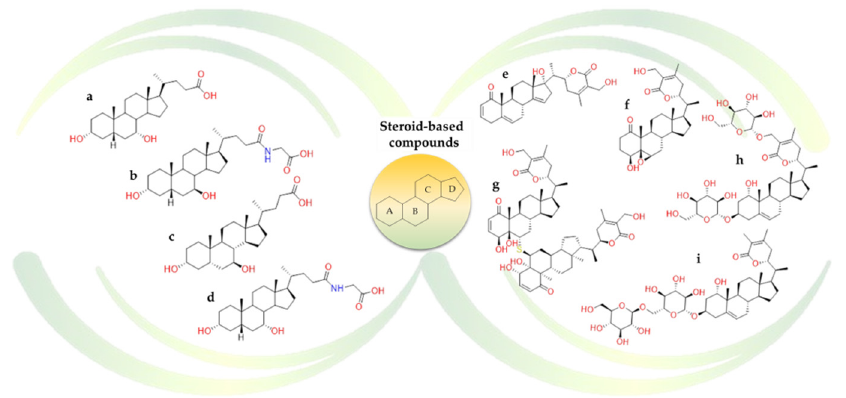
Figure 16. 2D structures of ( a ) chenodeoxycholic acid, ( b ) ursodeoxycholic acid, ( c ) Glyco-ursodeoxycholic acid, ( d ) glyco-chenodeoxycholic acid, ( e ) withanolide N, ( f ) dihydrowithaferin A, ( g ) ashwagandhanolide, ( h ) withanoside X, (i) withanoside V.